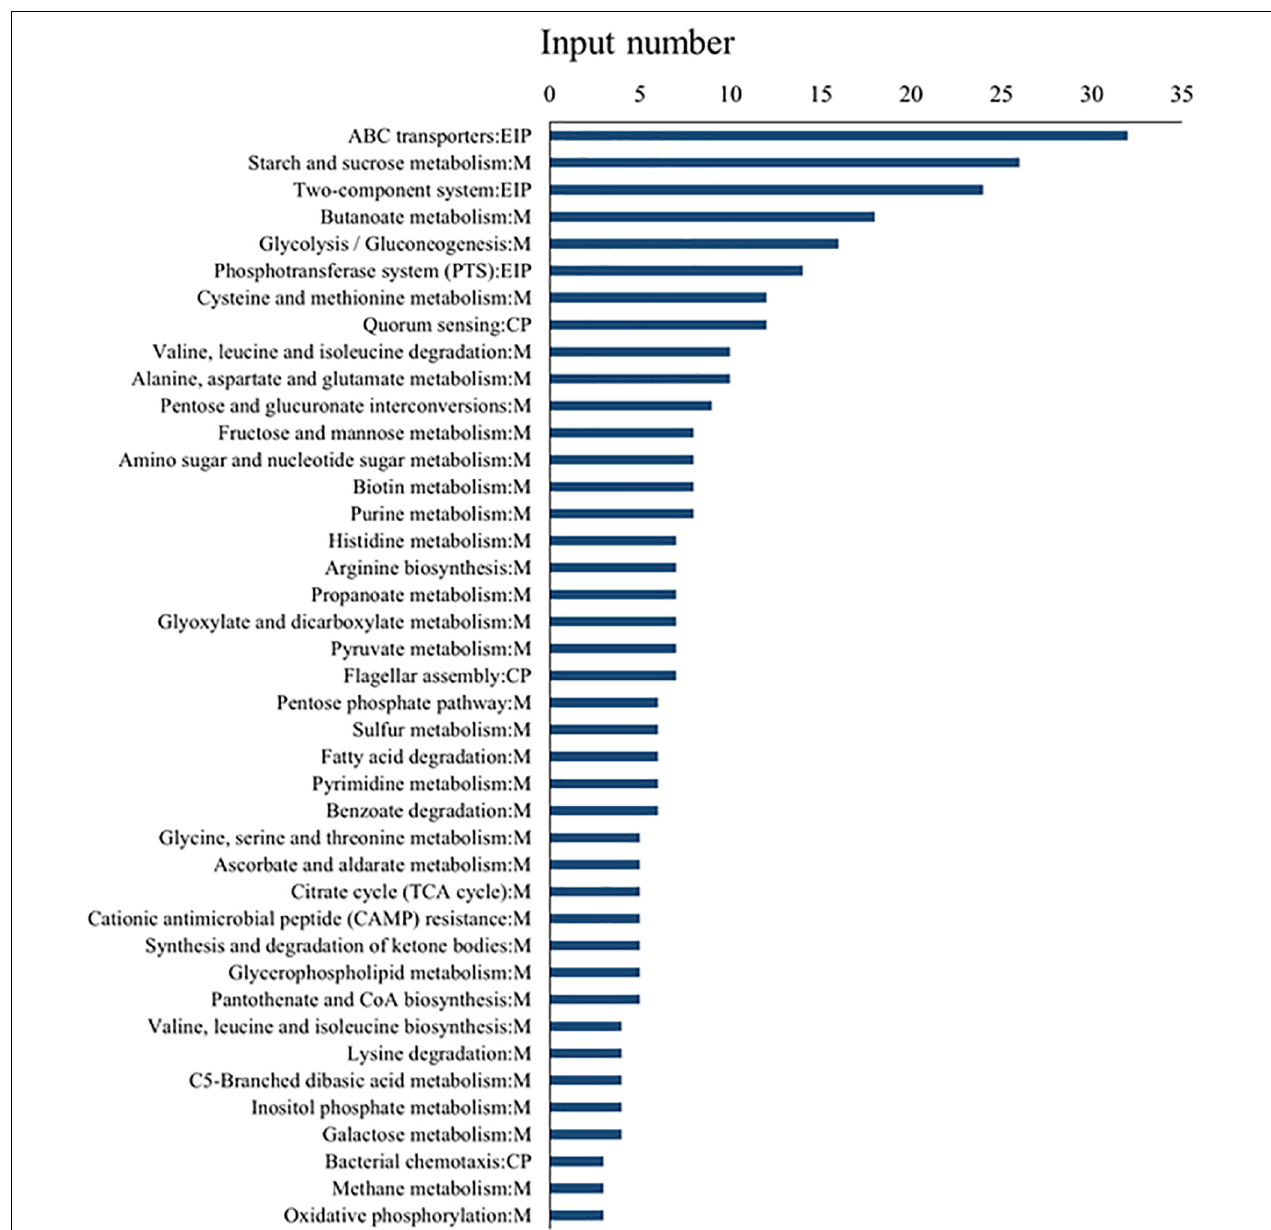
FIGURE 5 | KEGG pathway enrichment analysis of differential genes. Among them, EIP represents environmental information processing, M represents metabolism, and CP represents cellular processes.